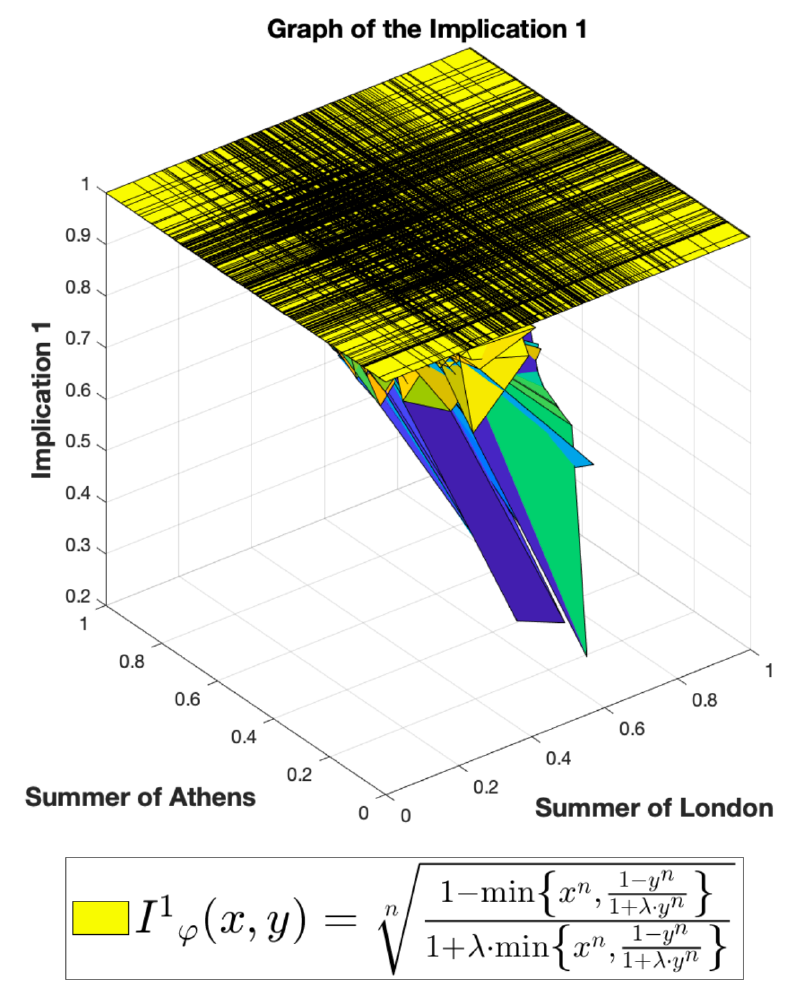
Figure 1. Graph of the Implication